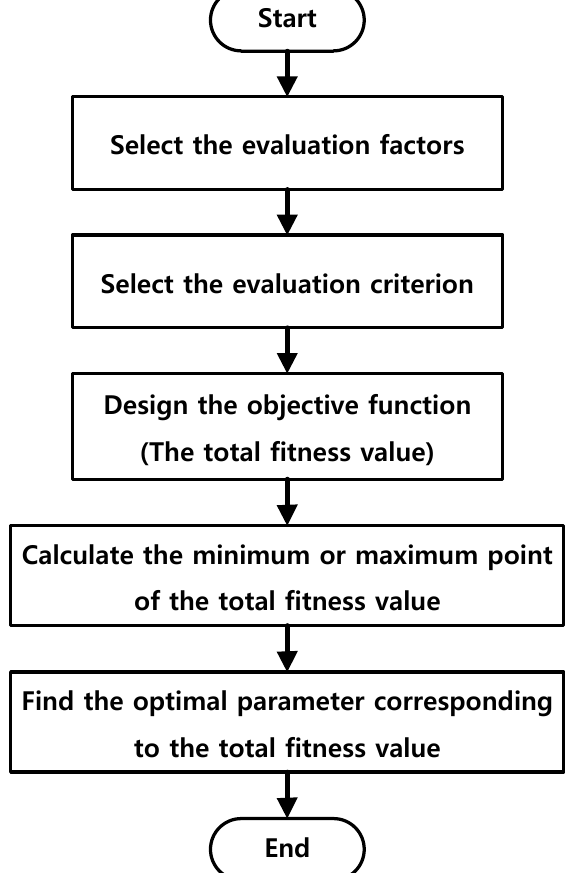
Figure 7. The flowchart for finding the optimal parameter using the penalty